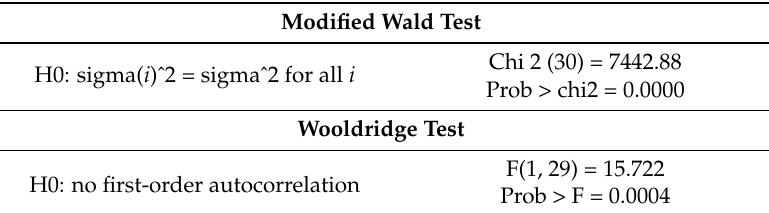
Table 3. Test results for heteroskedasticity and autocorrelation.